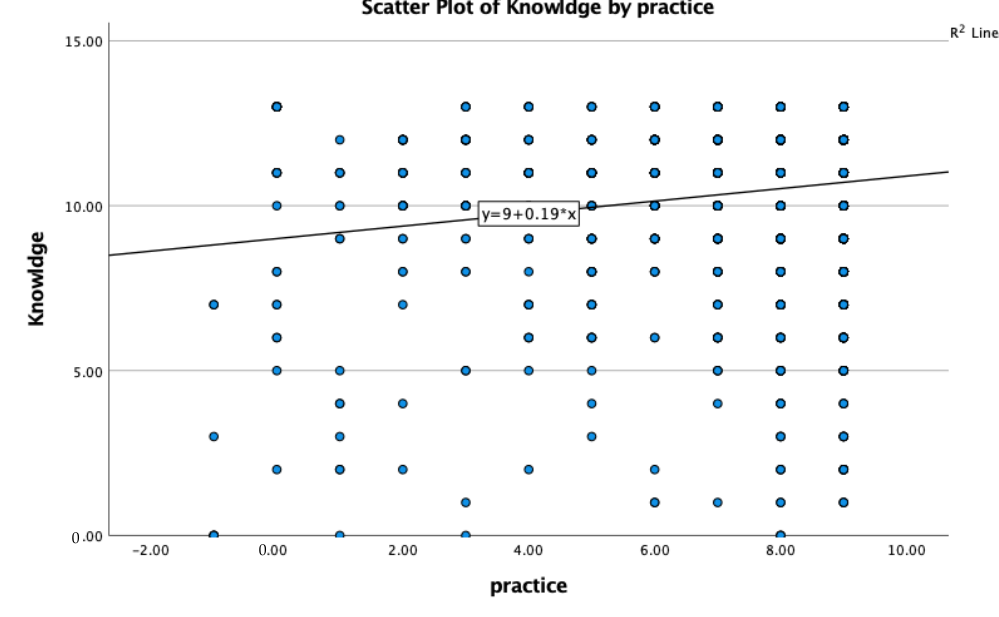
Figure 1. Knowledge and practice of the surveyed population a showed negligible positive association. Table 5. Association of the Spearman correlation between knowledge and practice. Correlations